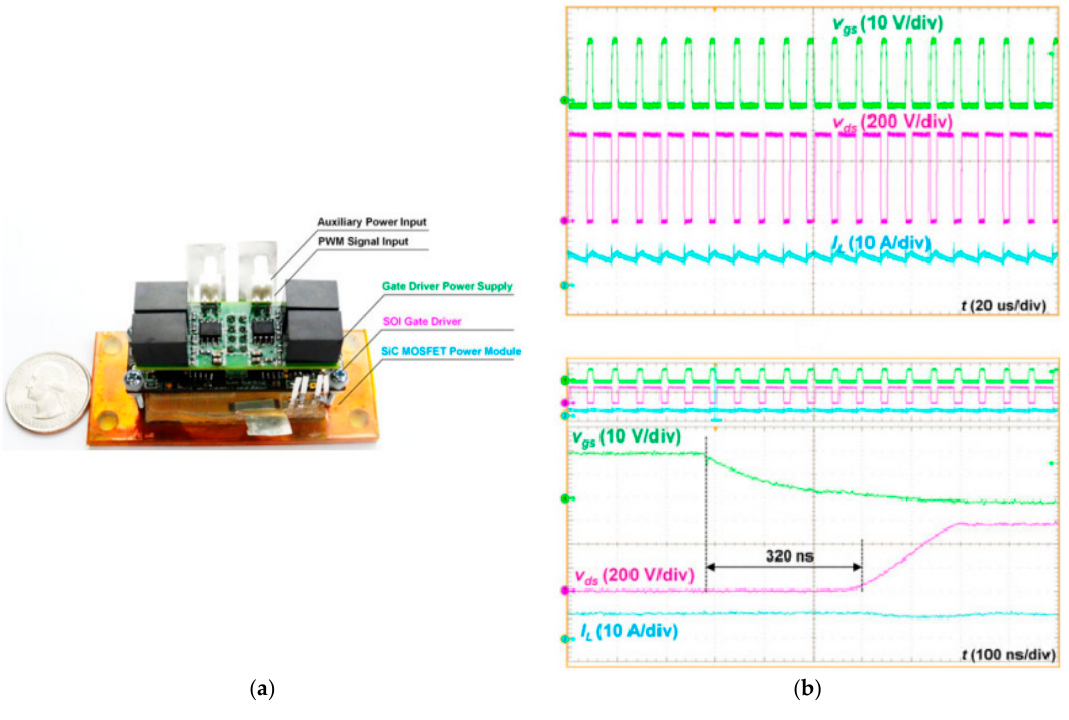
Figure 2. ( a ) A photograph showing the module developed by Wang et al. [27]; and ( b ) waveforms showing the operation of the power converter. SOI: silicon-on-insulator; and MOSFET: metal-oxide-semiconductor field-effect transistor. Reprint with permission [4062710688514]; Copyright 2014, IEEE.